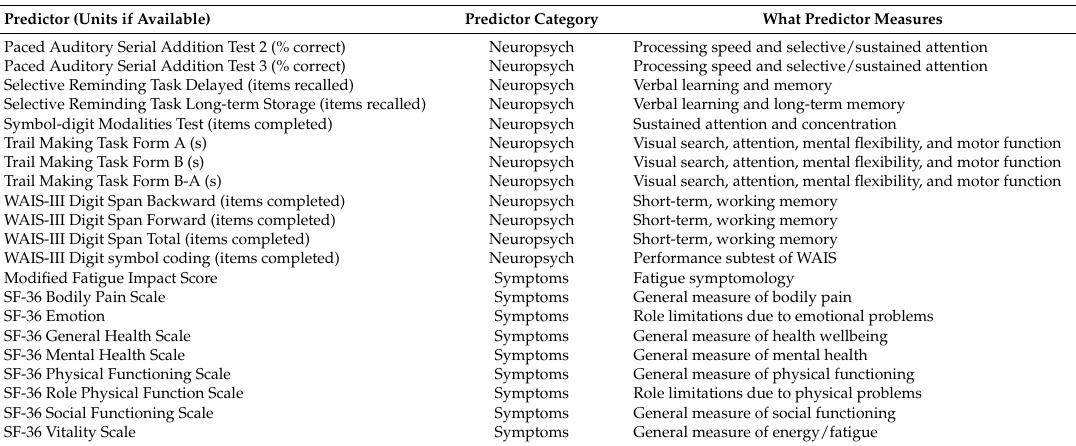
Predictor (Units if Available) Predictor